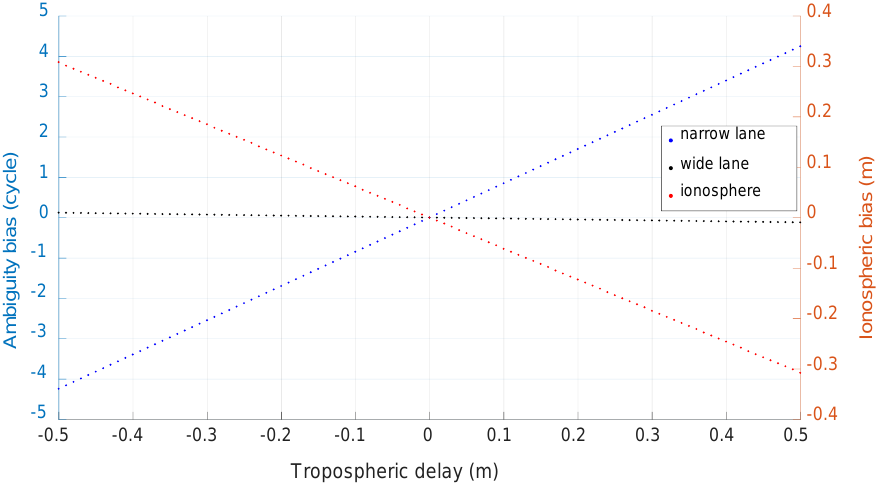
Figure 12. The caused bias of neglected tropospheric error (Galileo).